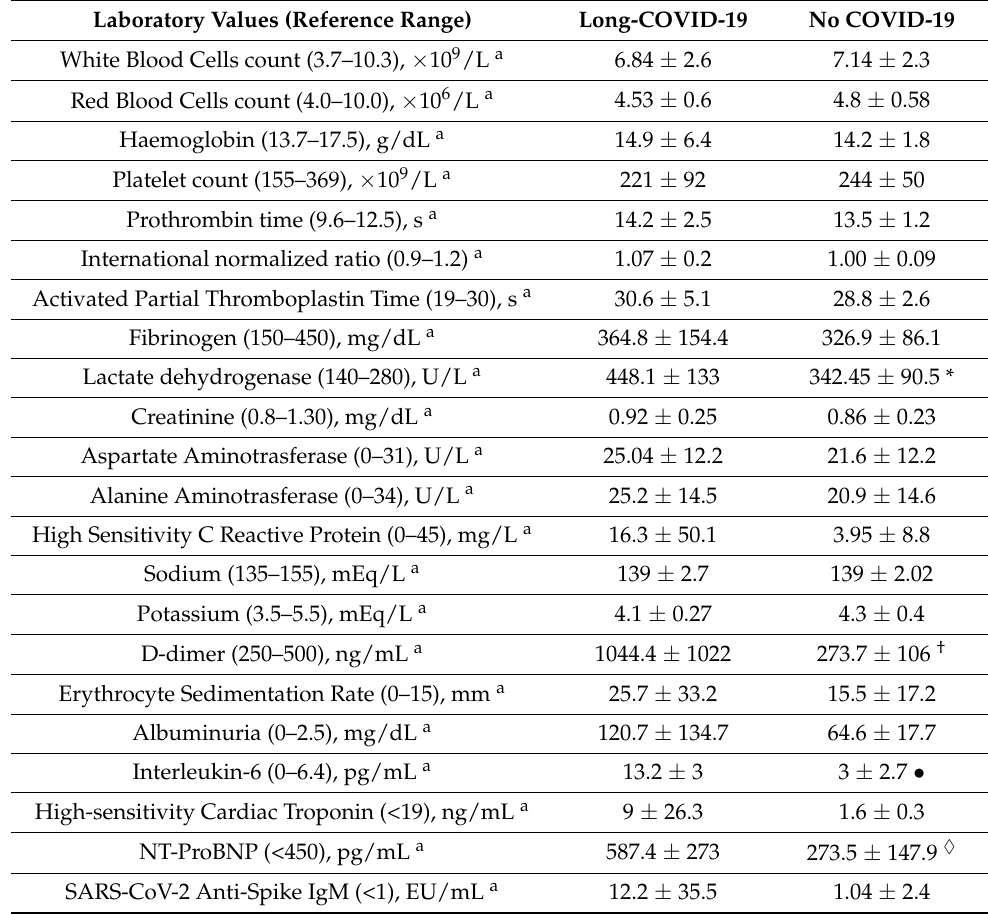
Table 3 summarizes laboratory data of Long-COVID-19 patients and no COVID-19 pa- tients; inflammatory parameters and coagulation pathway were higher in Long-COVID-19 patients. Table 3. Laboratory data of the study population. Laboratory Values (Reference